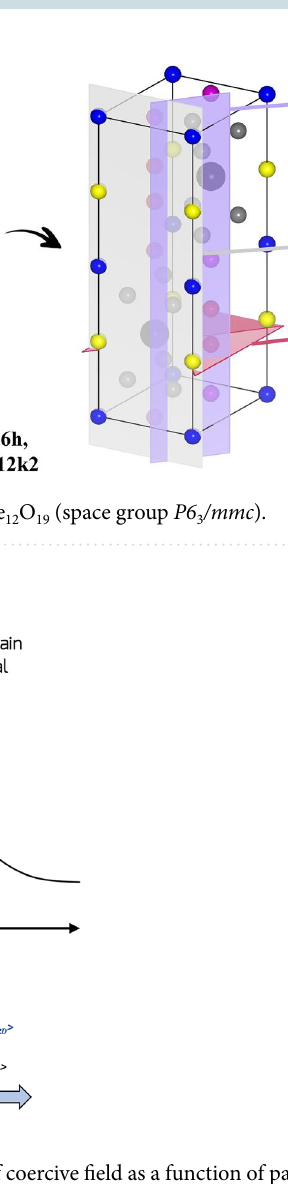
Figure 2. Top: Schematic illustration of the evolution of coercive field as a function of particle size showing the corresponding magnetization reversal processes (adapted from 15 ). SPS, SD, and MD stand for superparamagnetic state, single-, and multi-domain, respectively; D COH and D C for coherent and critical diameter, respectively. Bottom: Particles sketch with different size showing the growth of crystallites from single to polycrystalline. <D XRD > and <D TEM > indicate the crystallite and particle size,